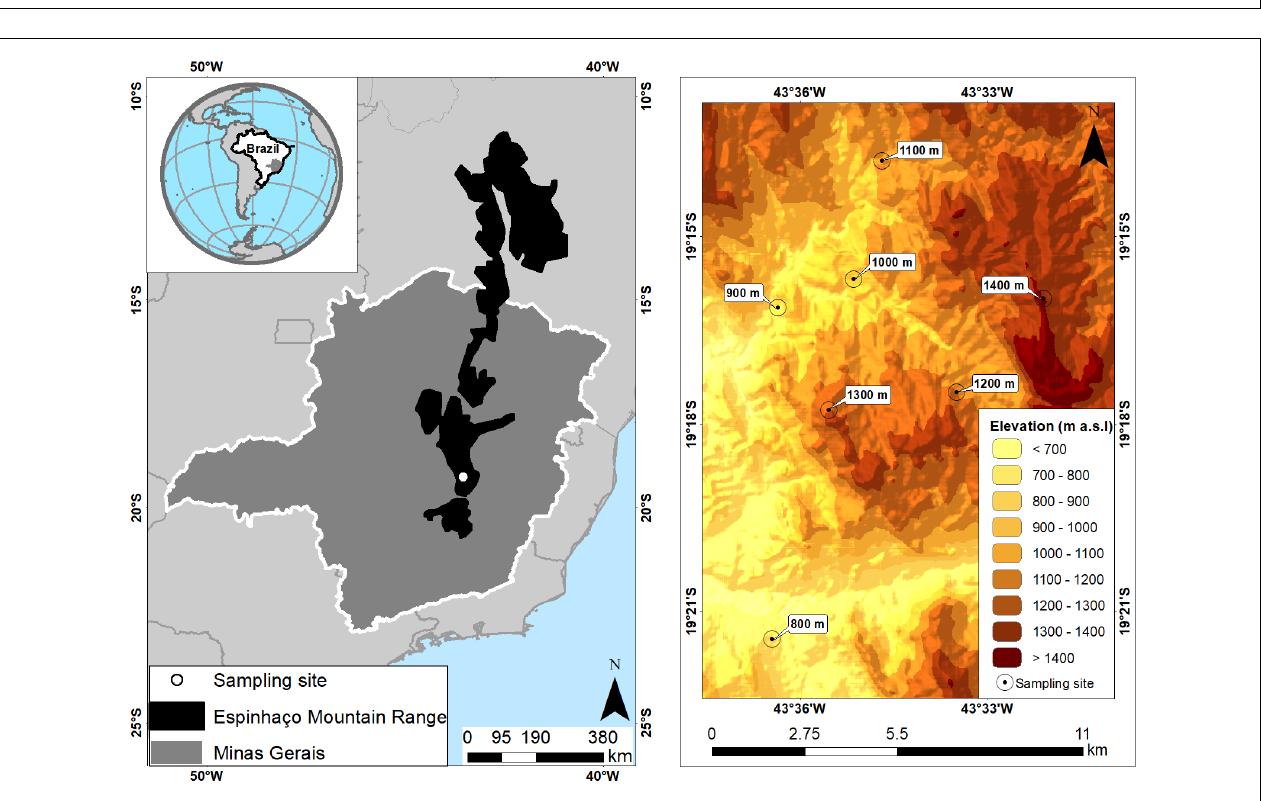
FIGURE 2 | Left panel shows a map with the location of the Espinhaço mountain range in Brazil, with our sampling area in the southern Serra do Cipó region, Minas Gerais. Right panel shows the distribution of the sampling sites along the elevational gradient.